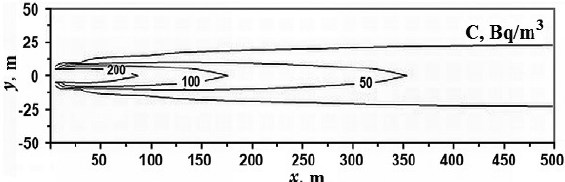
Figure 4. Isolines of concentrations of radionuclides ( C , Bq/m 3 ) in sea water one year after loss of sealing of the radiation source. The source is located in the origin of